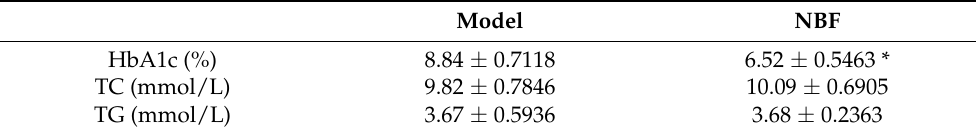
Table 3. Effects of NBF on HbA1c, TC, and TG in db/db